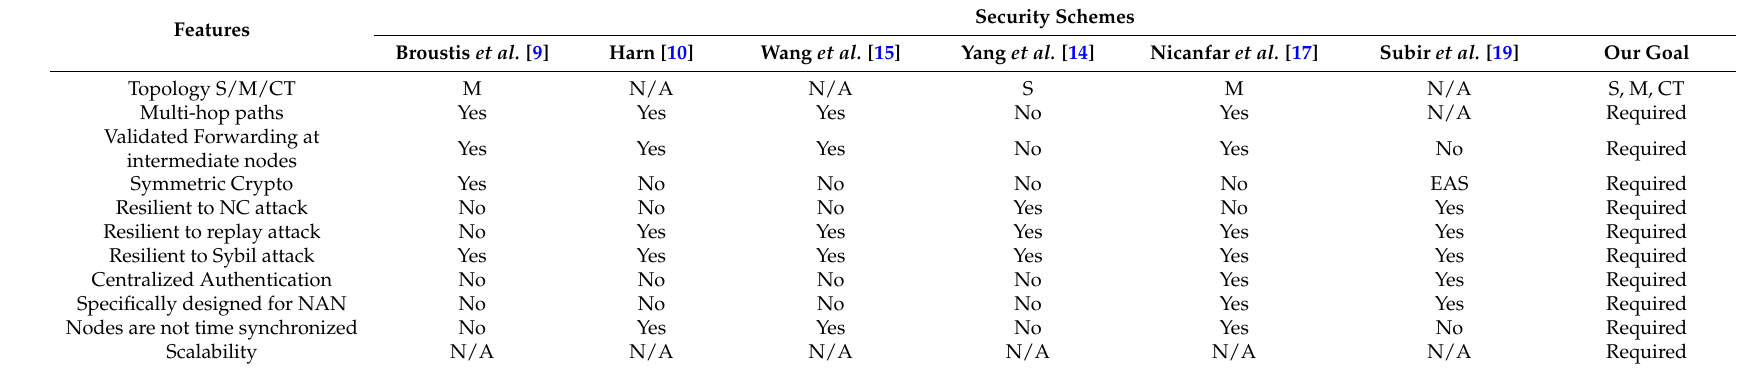
Table 1. A comparison of the availability of features in security